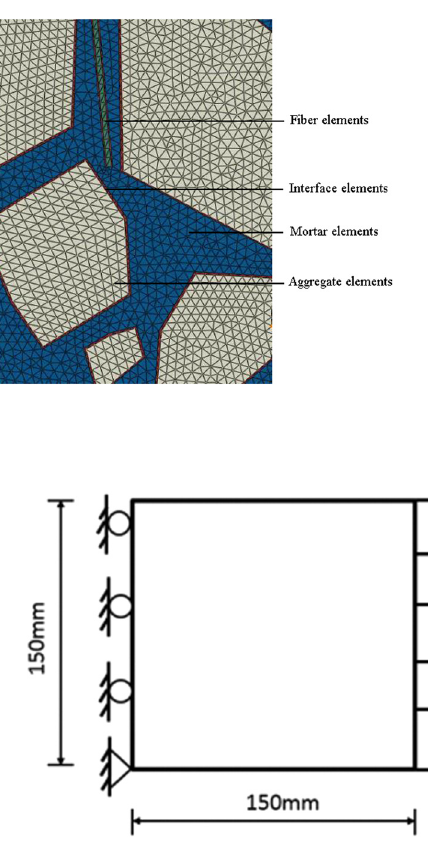
Figure 6: Uniaxial tensile plane model of